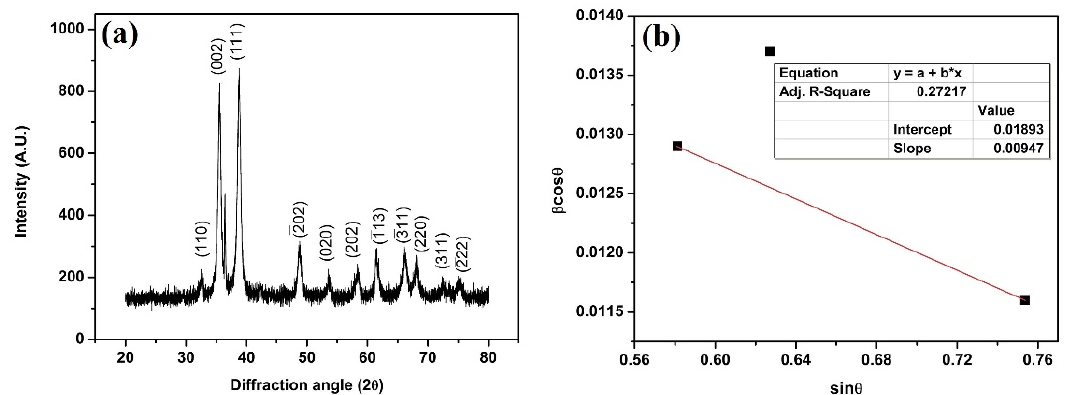
Figure 4. ( a ) XRD diffraction spectra of green synthesized CuO NPs, followed by ( b ) Williamson-Hall Plot to calculate lattice strain.